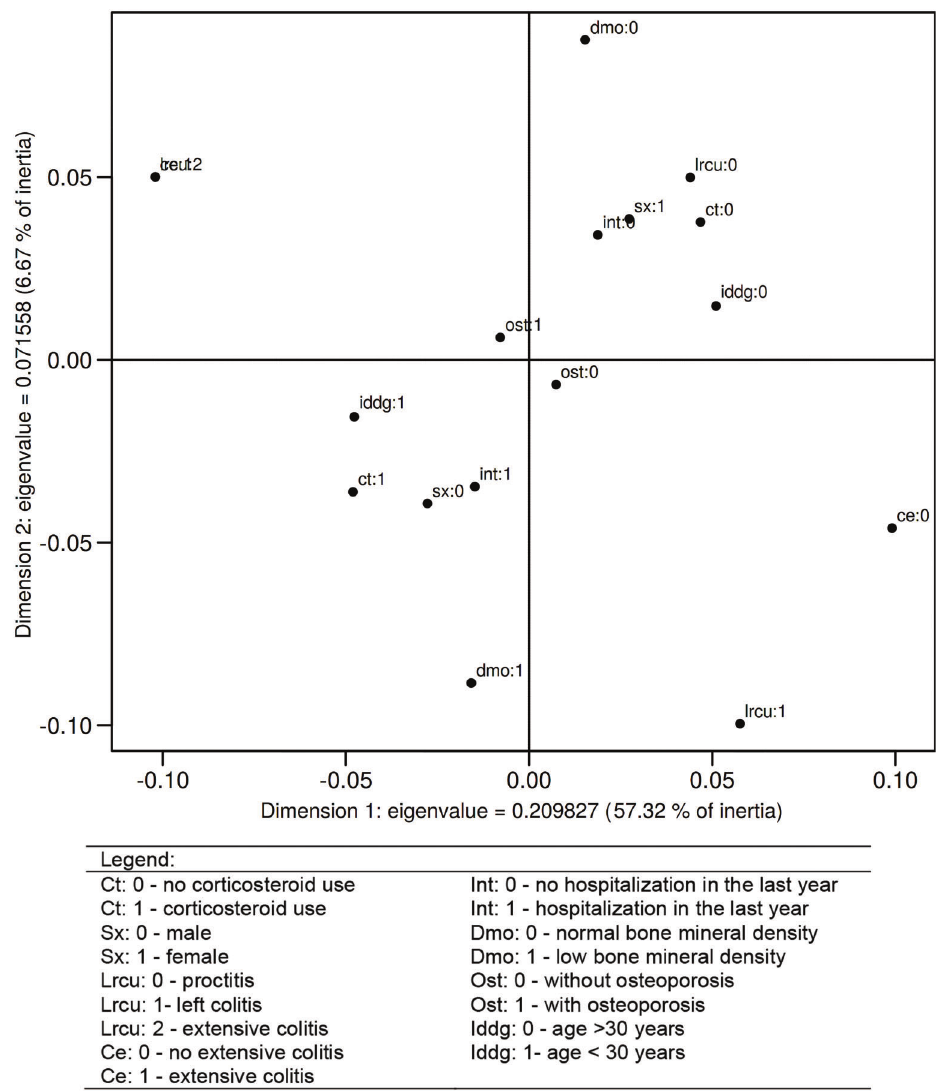
Figure 2. Multiple correspondence analyses for categorical variables in ulcerative colitis